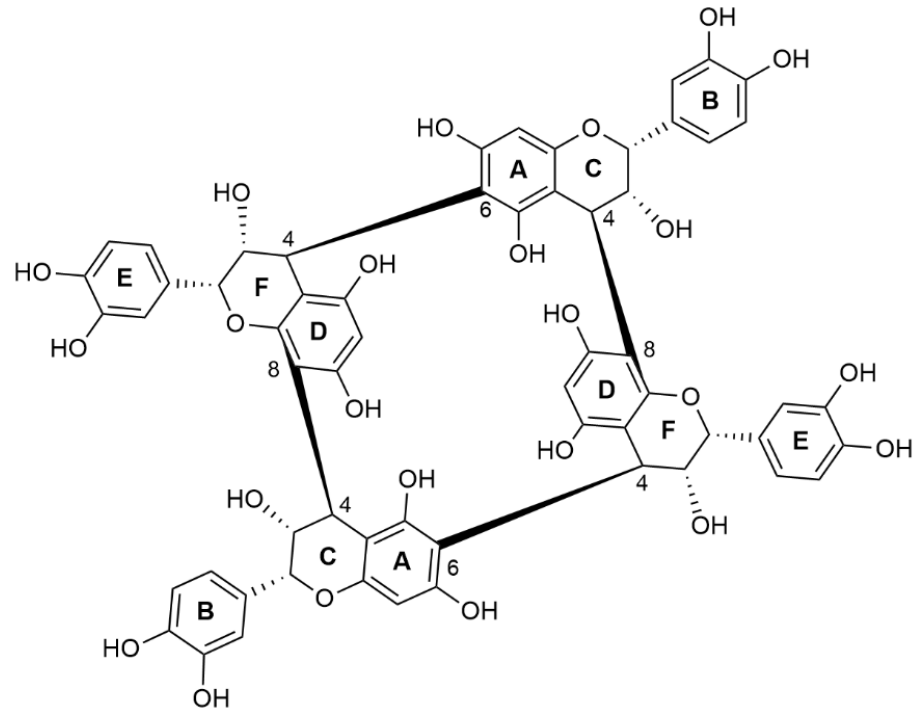
Figure 1. Structure of the crown procyanidin tetramer.